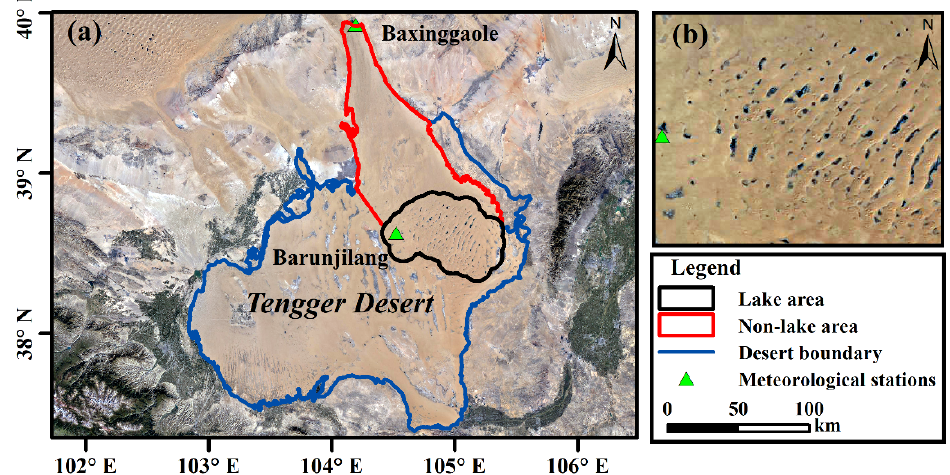
Figure 1. ( a ) Study area and distribution of meteorological stations in Tengger Desert and ( b ) lake-group region located in the northeastern region. region located in the northeastern